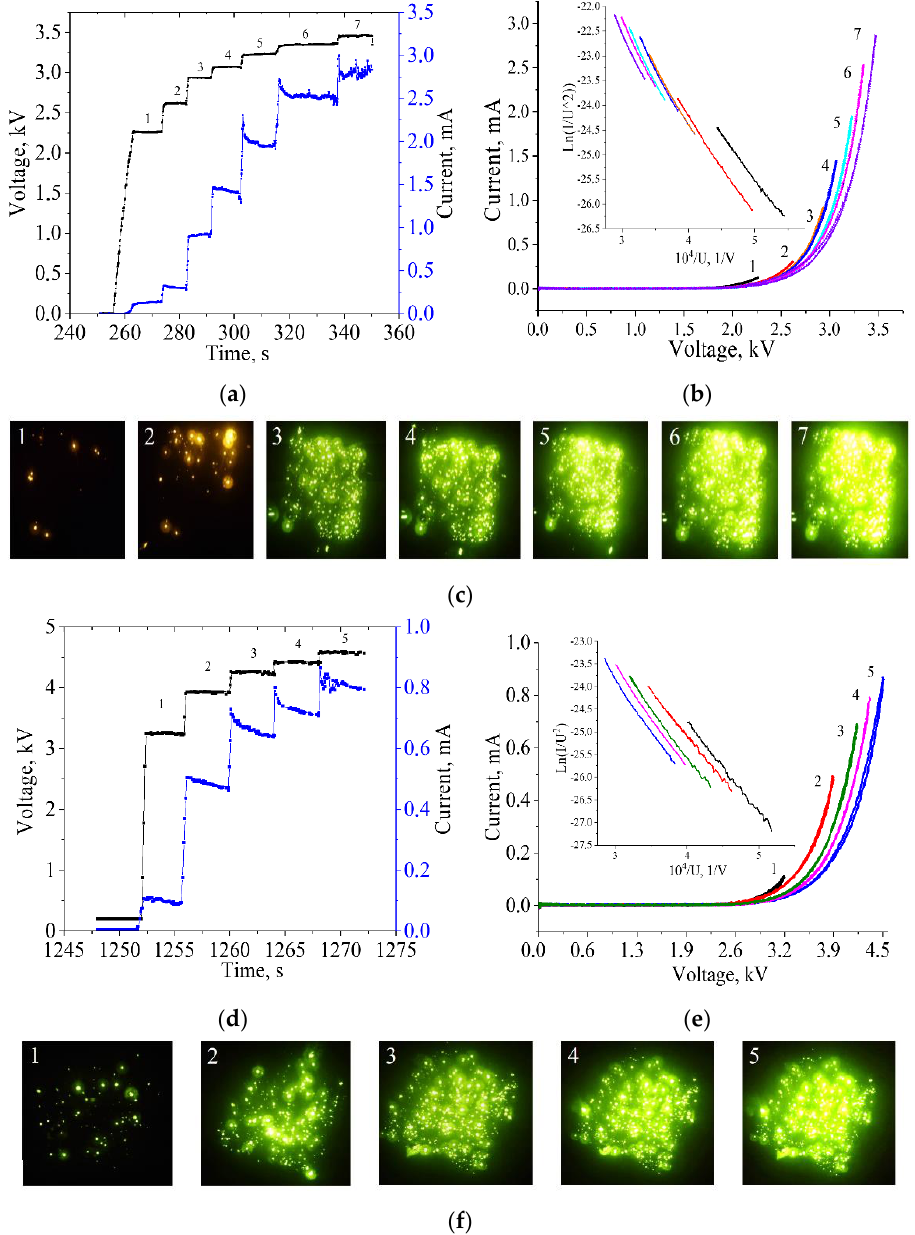
Figure 2. Training of cathodes by voltage steps for pristine CNT ( a ) and CNT/NiO ( d ), IVCs for samples (corresponding to the step numbers and glow patterns ( c , f )) and corresponding IVC in Fowler − Nordheim coordinates (in inserts) for pristine CNT ( b ) and CNT/NiO ( e ). To calculate statistical distribution of the effective field enhancement factor ( β eff ) and emission area ( A eff ), the standard IVC regression analysis in semi-logarithmic Fowler – Nordheim coordinates, according to Equation (1), was applied. Figure 3a shows histo- grams of fluctuations of the mentioned effective parameters. The average values were for